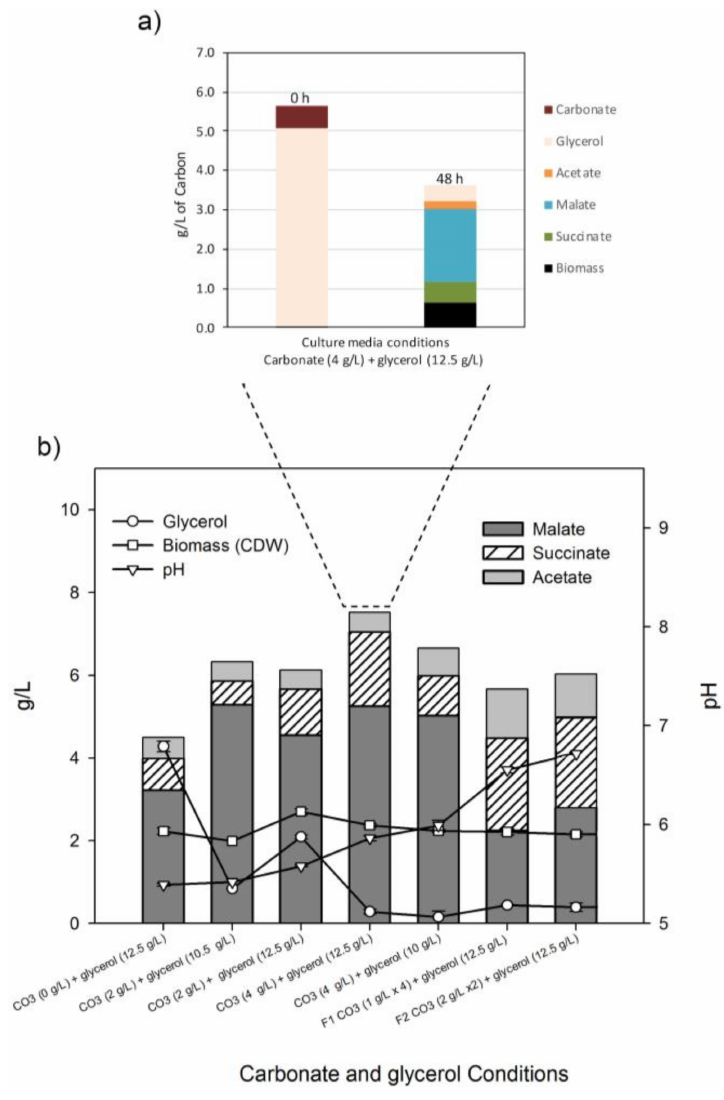
Figure 5. Elemental C analysis ( a ) and summary of bicarbonate and glycerol concentration assays at 48 h ( b